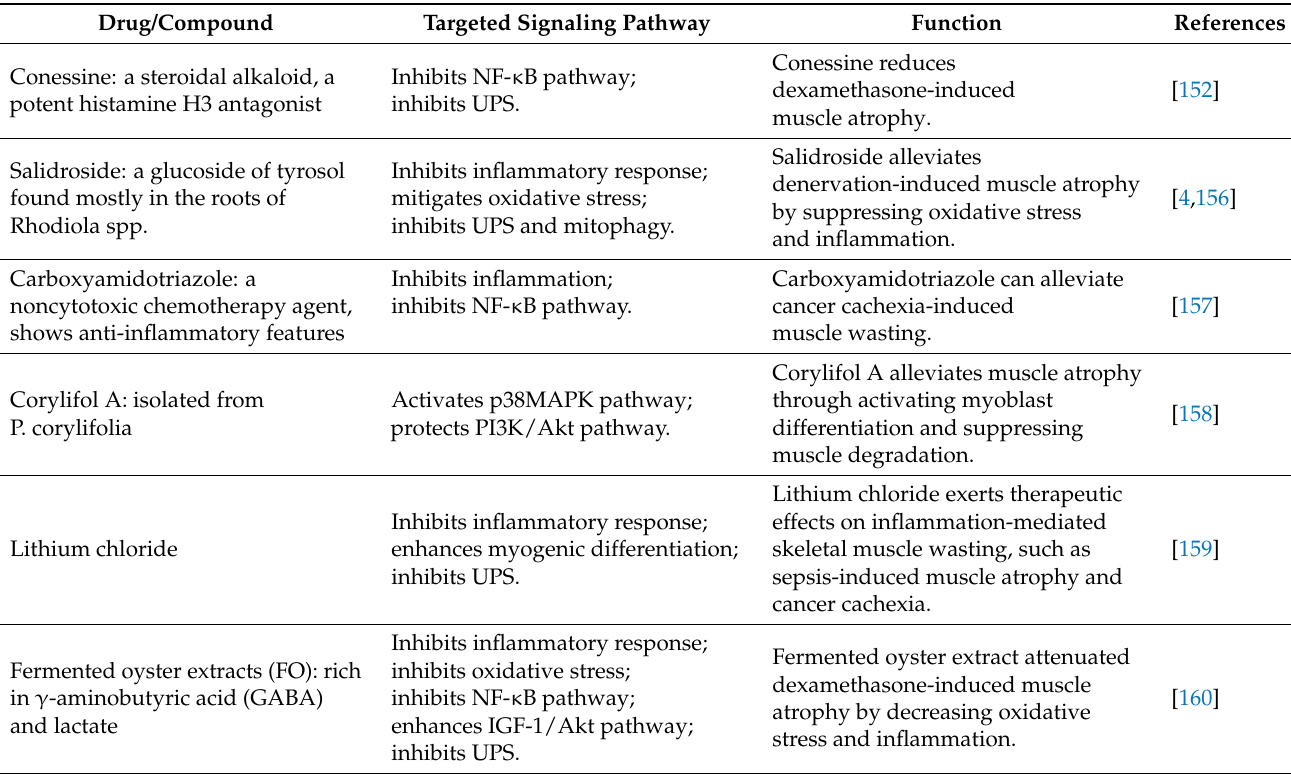
Table 1. Drugs targeting inflammation in the treatment of skeletal muscle